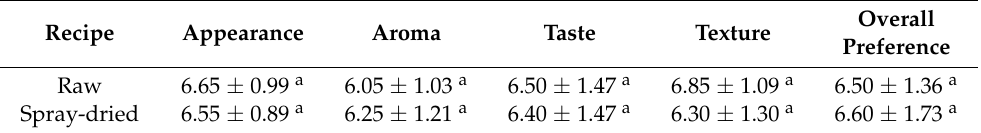
Table 5. Sensory profile (appearance, aroma, taste, texture, and overall preference) of sponge cakes containing split yellow pea raw cooking water (raw) or reconstituted pea cooking water powder (spray-dried). Different letters represent statistical difference ( p <